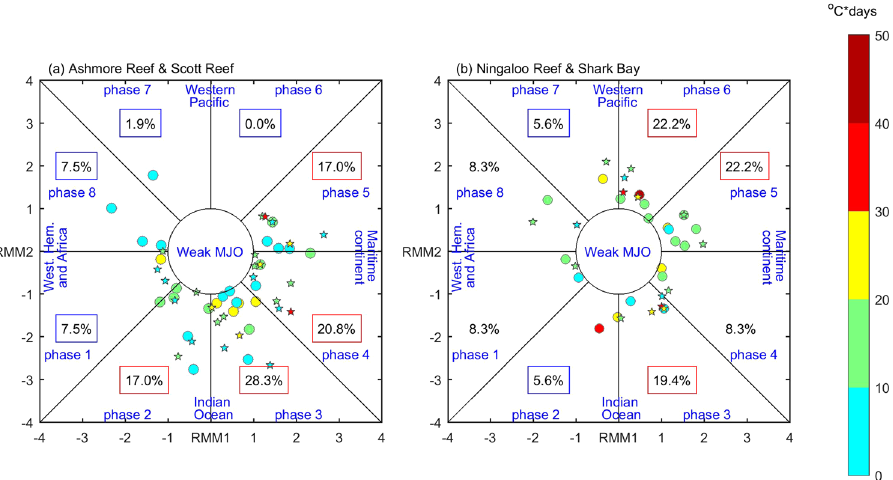
Figure 6. Distribution of the MHW peaks in extended summer months as a function of MJO phases at ( a ) the tropical Ashmore (circles) and Scott Reefs (stars) and ( b ) subtropical Ningaloo Reef (circles) and Shark Bay (stars). The percentages stand for the proportions of MHW peaks in that phase of strong MJO and are boxed in red (blue) where they are significantly greater (less) than the average occurrence (8.3%). Only MHWs with duration of less than 20 days are shown. Figures are plotted using MATLAB R2015b (http://www.mathworks.